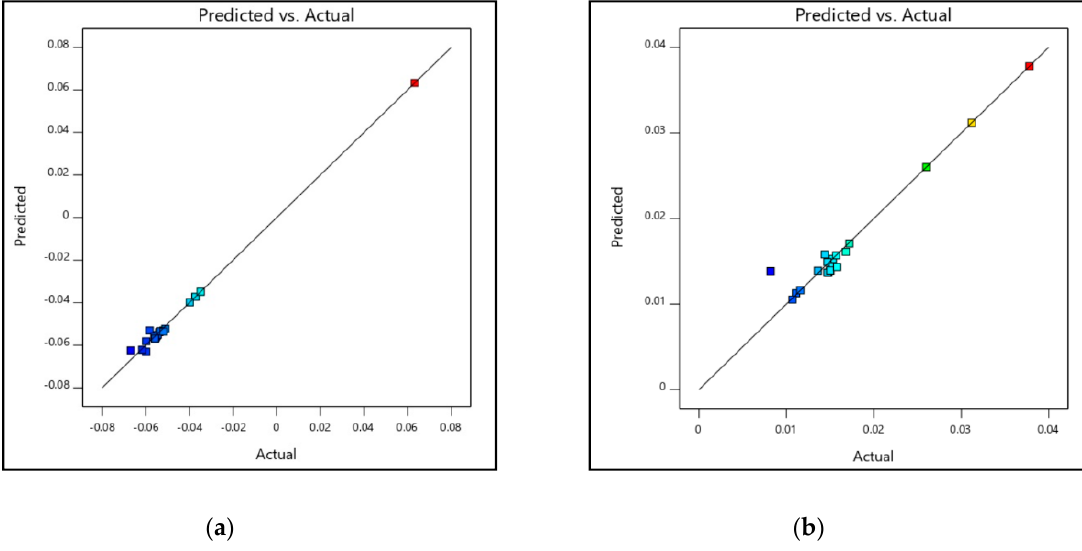
Figure 10. Predicted vs. actual for double story housing based on two types of concrete: ( a ) fly ash, ( b ) blast furnace slag.